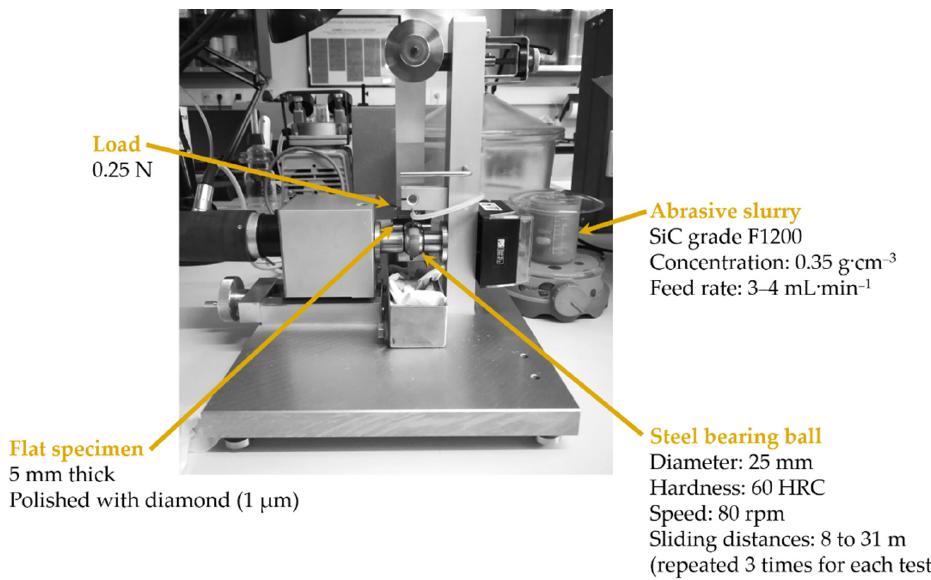
Figure 2. Microscale abrasion tester and selected parameters.